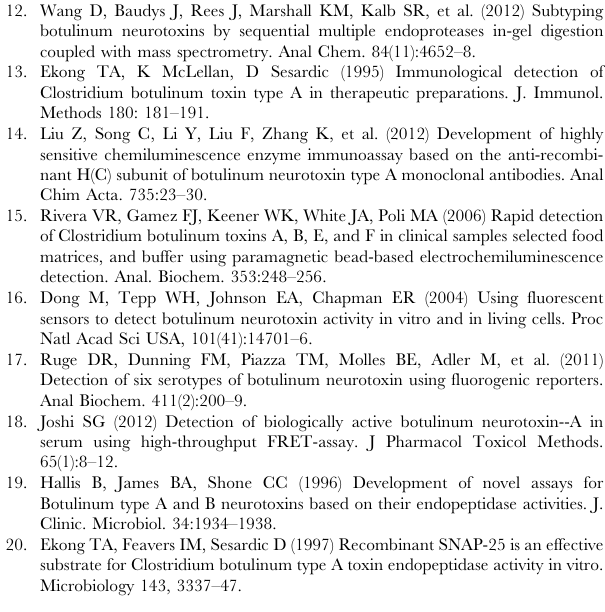
Table S1 the concentration-response relations between OD 450 and ALc with different buffer combination. Table S2 the concentration-response relations between OD 450 and ALc with different reaction time and temperature combina-